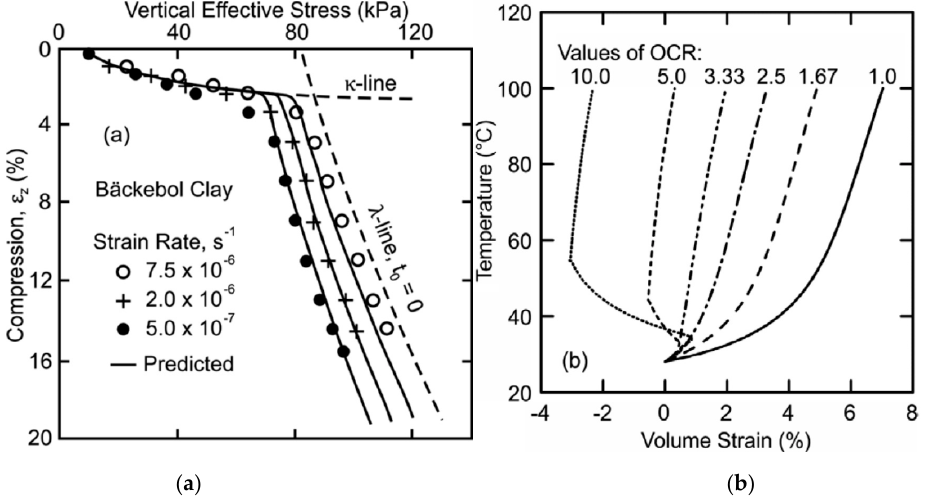
Figure 9. ( a ) Differences in compression behavior with changes in strain rate [179], ( b ) Temperature versus volume strain during heating at constant isotropic pressure for various over-consolidation ratios (OCRs) from the ETVP model with the creep rate coefficient defined by an exponential relationship [162].